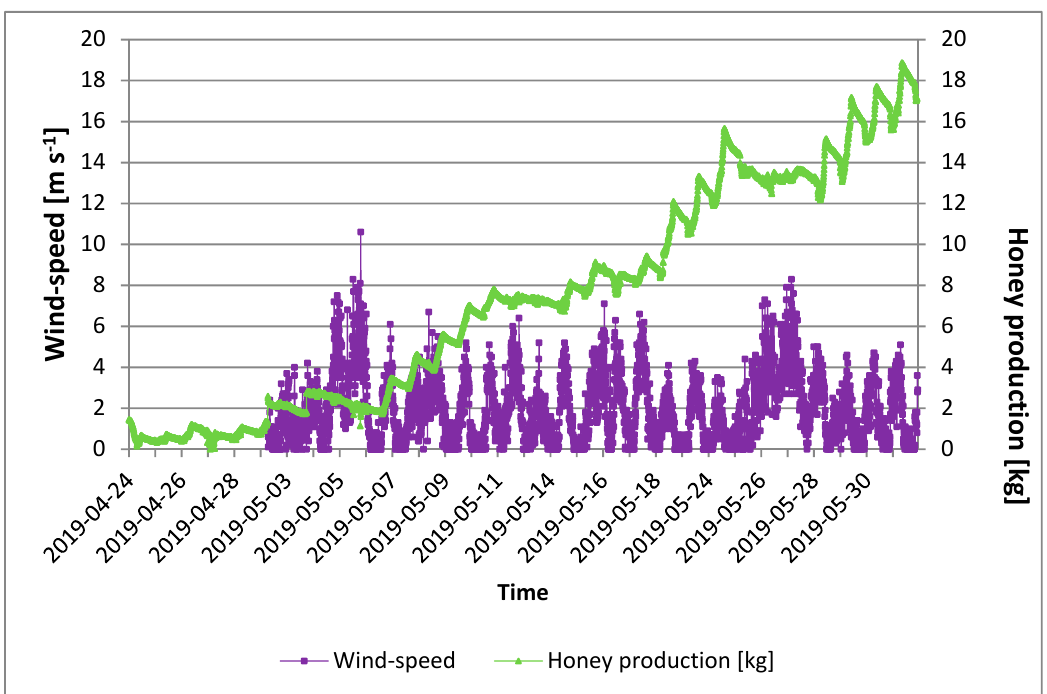
Figure 10. Daily quantity of honey produced as a function of external wind speed (data are the mean of three replicates).